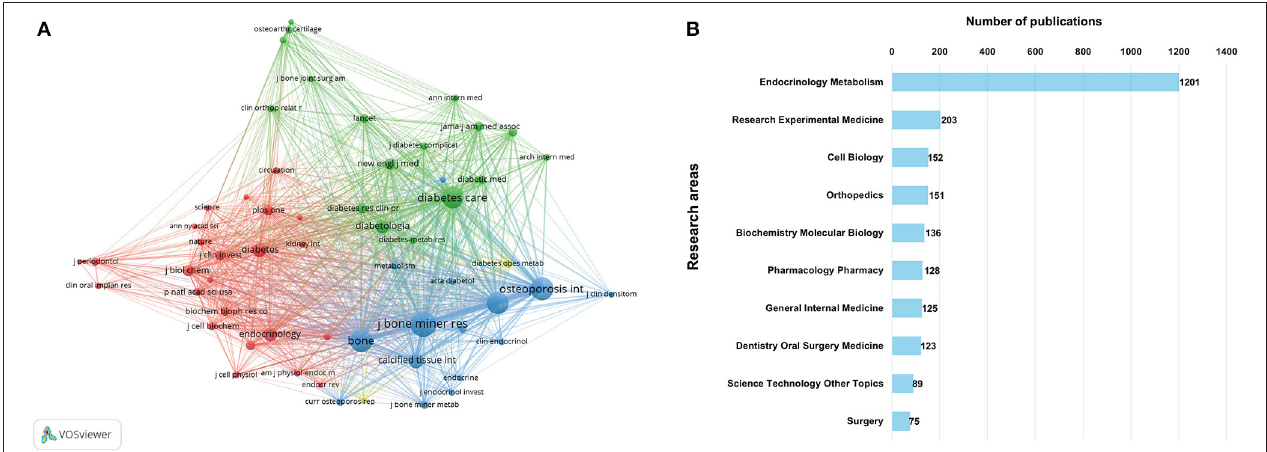
FIGURE 6 | (A) Network visualization map of journal co-citation analysis generated by VOSviewer. (B) Top 10 research areas ranked by publication counts.